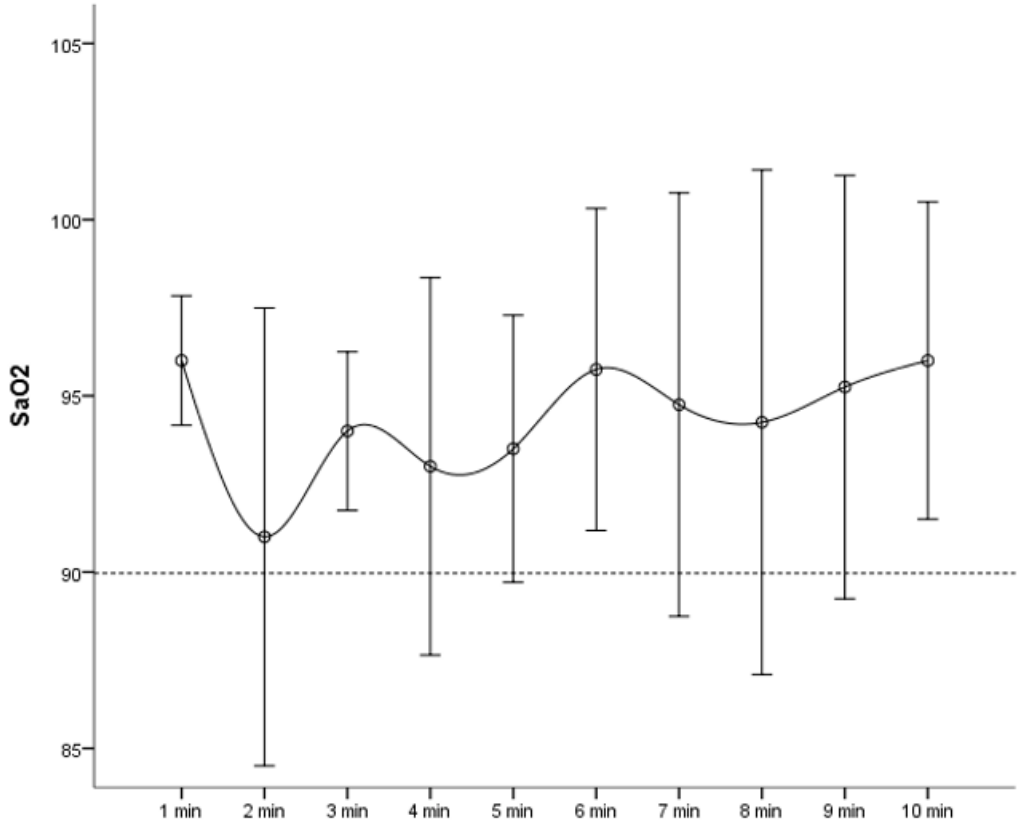
Figure 2. Mean oxygen saturation (%) in patients with hypoxic event by time (minutes) ( n = 28).